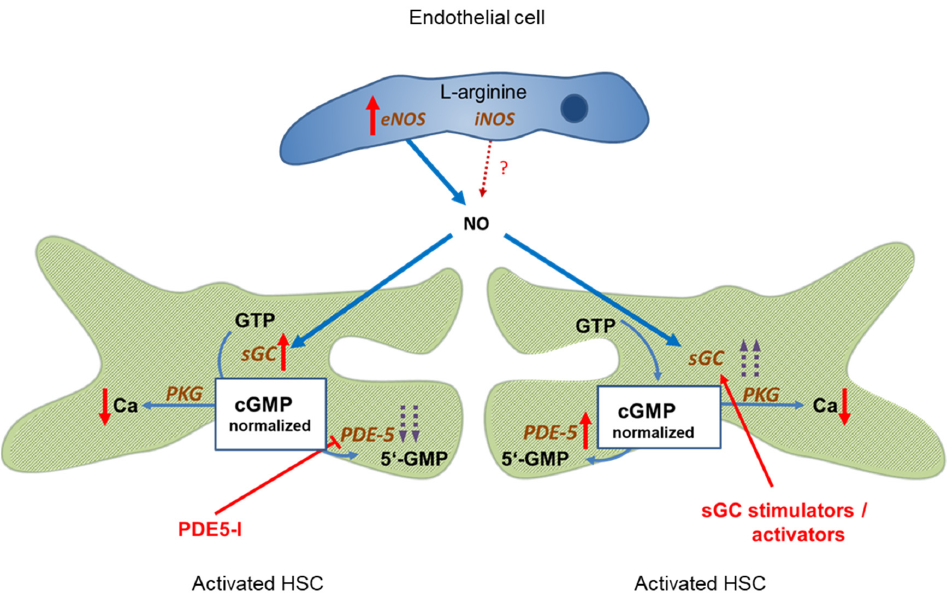
Figure 2. Targeting the NO-cGMP pathway for therapy of portal hypertension. Left side: Administration of PDE-5 inhibitors in liver cirrhosis leads to normalization of cGMP concentration and sinusoidal dilation. Portal pressure decreases and portal blood flow increases. Right side: Enhancing sGC activity in liver cirrhosis using an sGC stimulator or activator leads to increased cGMP levels and decreased sinusoidal tone. Portal pressure decreases and portal blood flow increases. ↑ increased expression; ↑↑ markedly increased expression; Ca ↓ decreased concentration; inhibition; stimulation/activation.